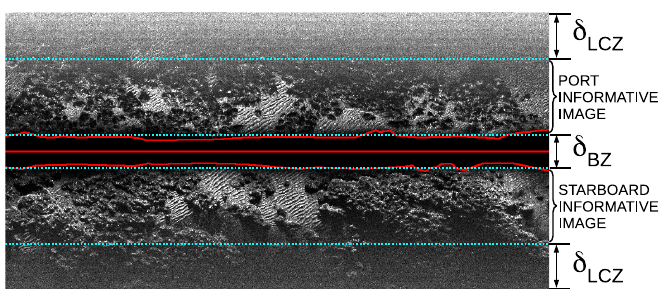
Figure 4. Example of intensity and slant corrected acoustic image. The blind zone as well as the central bins, separating port and starboard, are outlined. The blind and low contrast zones under constant altitude and flat floor assumption are also